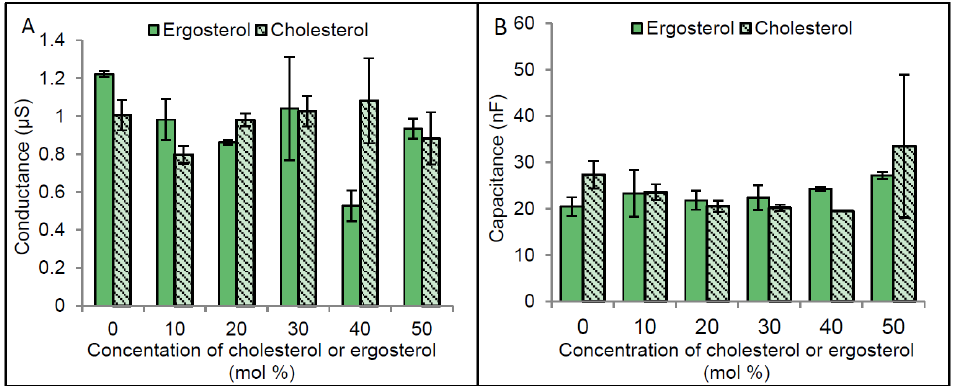
Figure 5. Conductance and capacitance of membranes containing different concentrations of cholesterol or ergosterol. Bilayer lipid membranes were formed using 10% tethered lipids on a gold electrode representing the monolayer of membrane and zwitterionic lipids dissolved in ethanol containing different concentrations of cholesterol or ergosterol was used as the second layer for the membrane. Membranes were then rapidly flushed with HEPES/KCl buffer (pH 6.5) in order to remove the ethanol by solvent exchange method and enhance the formation of the bilayer lipid membranes. The conductance and the capacitance of membranes were measured using impedance spectroscopy. ( A ) Represents membrane conductance at different cholesterol or ergosterol concentrations and ( B ) Capacitance of membrane with different cholesterol or ergosterol concentrations. The error bars represent the standard error of three independent impedance spectroscopy conductance measurements.